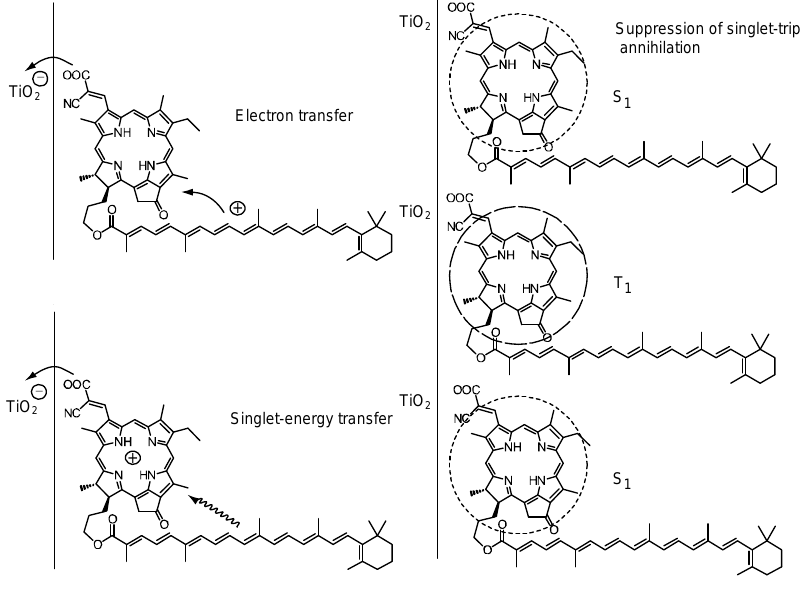
indicated) in the solar cell using the Phe–Car adduct sensitizer (reprinted from [19], Copyright (2007), with permission from